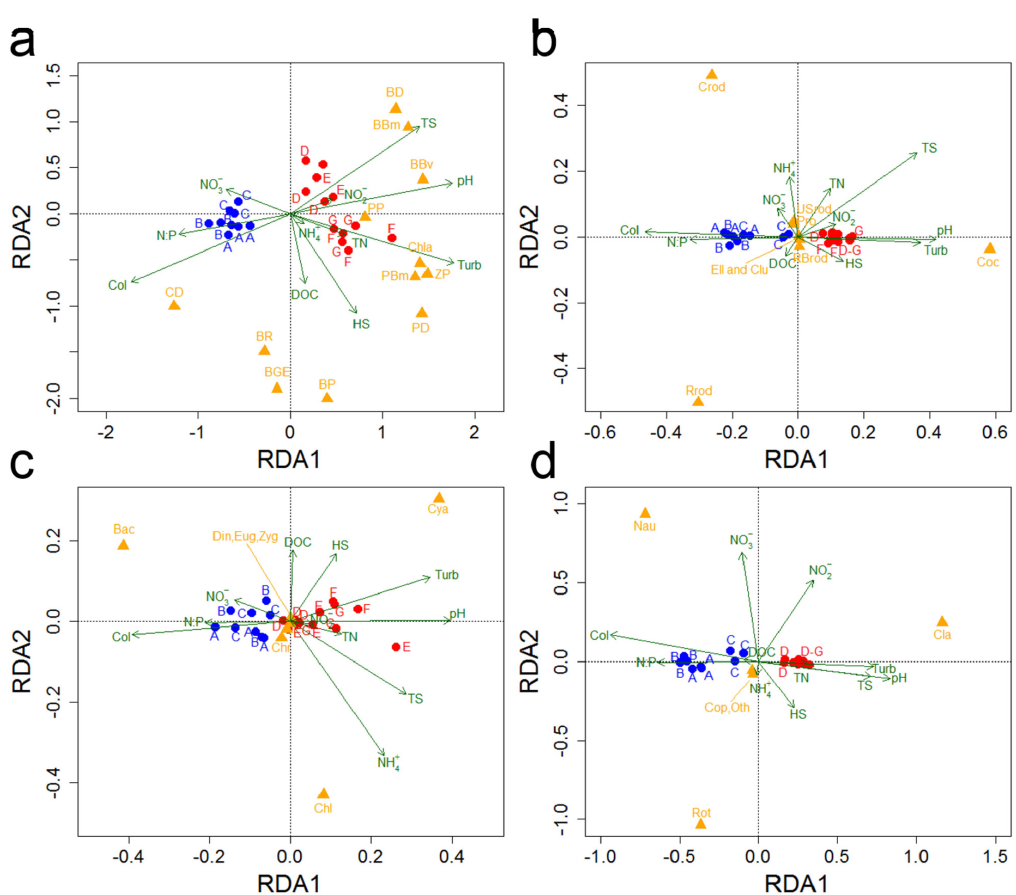
Figure 6. Redundancy Analyses (RDA) of (a) Bulk community measurements and metabolic rates, (b) Bacterial morphotypes, (c) Phytoplankton groups and (d) Zooplankton groups as response variables and limnological variables as explanatory variables. Refer to Table 2 for more details about the analysis. Colors refer to: yellow, response variables; green, explanatory variables; blue, stations A-C from the littoral zone; red, stations D-G from the pelagic zone. Abbreviations: (BP) bacterial production, (BR) bacterial respiration, (BGE) bacterial growth efficiency, (BD) bacterial density, (BBv) bacterial biovolume, (BBm) bacterial biomass, (PD) phytoplankton density, (PBm) phytoplankton biomass, (PP) primary production, (Chla) chlorophyll a, (ZP) zooplankton density, (CD), ciliate density, (Coc) coccus, (Rrod) regular rod, (Crod) curved rod, (USrod) u-shaped rod, (Ell) ellipsoid, (Pro) prosthecate, (RBrod) rudimentary branched rod, (Clu) club, (Bac) Bacillariophyceae, (Chr) Chrysophyceae, (Chl) Chlorophyceae, (Cya) Cyanobacteria, (Din) Dinophyceae, (Eug) Euglenophyceae, (Zyg) Zygnemaphyceae, (Cop) Copepoda, (Nau) nauplii, (Cla) Cladocera, (Rot) Rotifera, (Oth) others, (TN) total nitrogen; (NO 3- ) nitrate, (NO 2- ) nitrite, (NH 4+ ) ammonium, (DOC) dissolved organic carbon, (pH) potential of hydrogen, (Col) water color, (Turb) turbidity, (HS) humic substances ratio, (TS) total solids, (N:P)